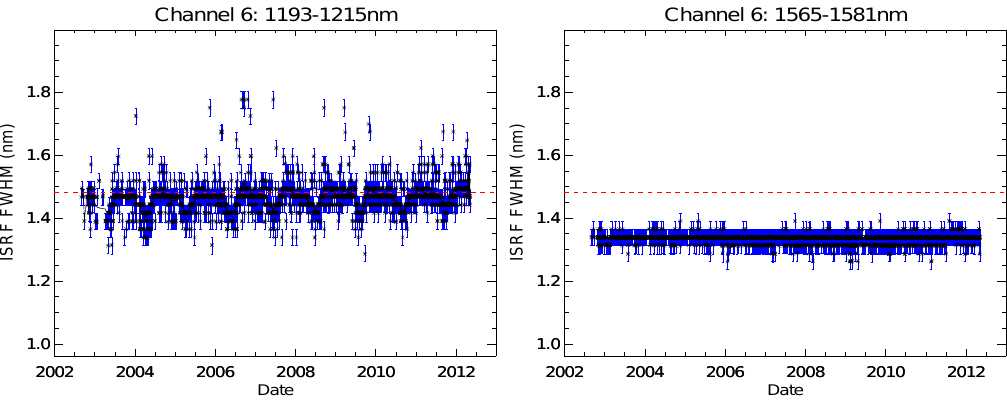
Figure 16. Similar to Figure 11 but for Channel 6. The two plots correspond to the two spectral lines from Table 4. The black line in the left plot is a smoothed curve of the FWHM.